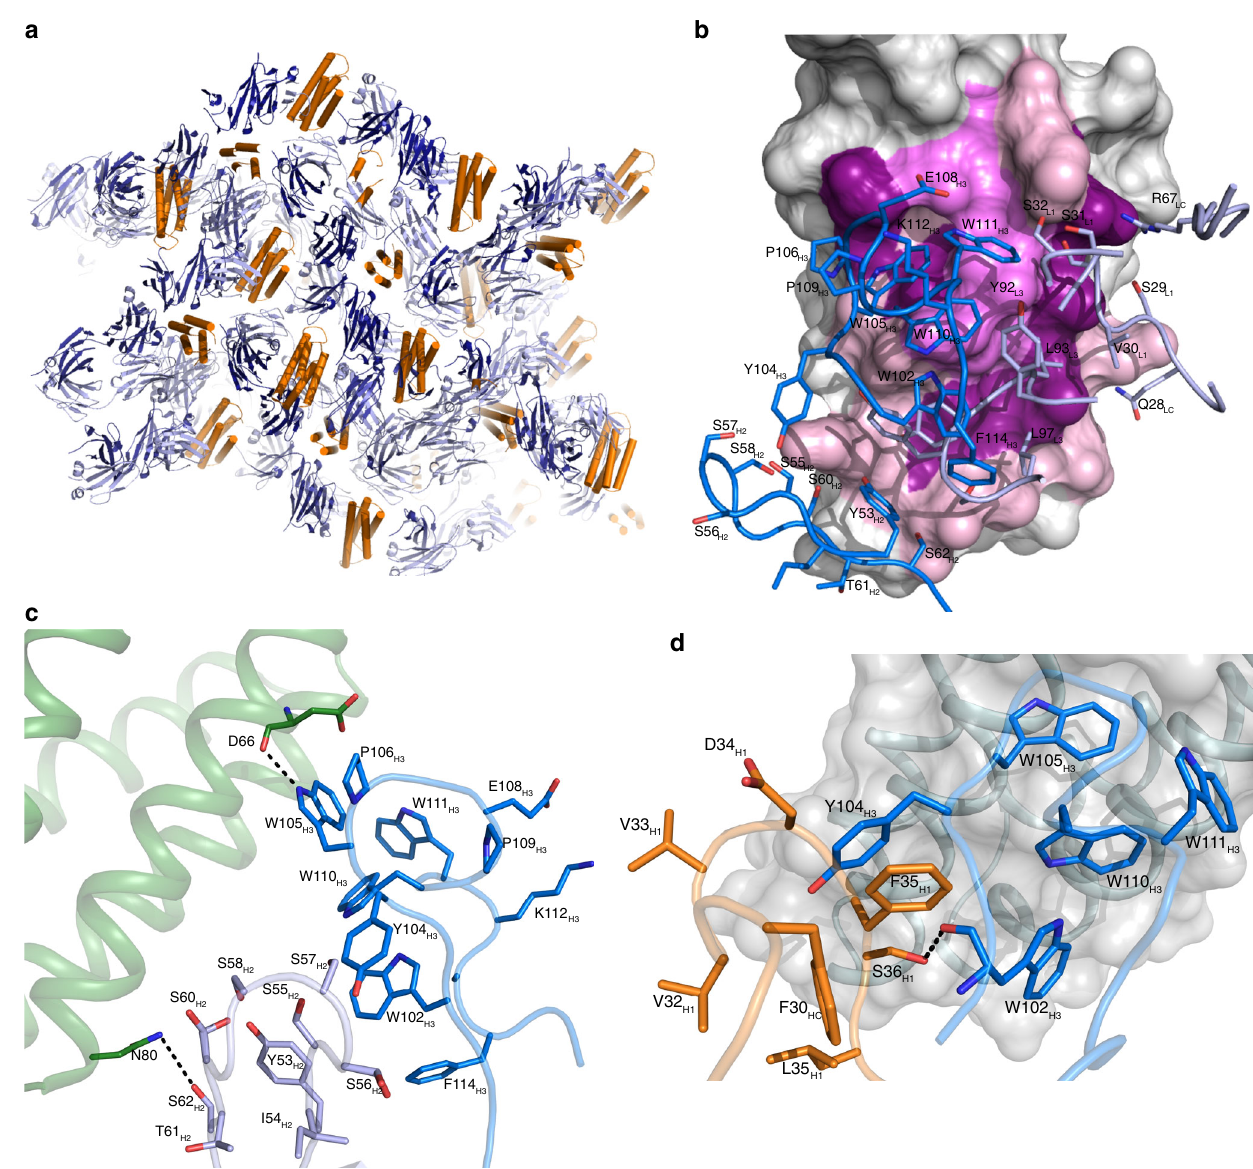
Fig. 4 Structural characterization of the BRIL – BAG2 complex. a Analysis of the crystal packing shows the contacts in the crystal lattice are mediated primarily by BRIL and the heavy chain (HC) and light chain (LC) of BAG2. BRIL is colored orange while the HC and LC of BAG2 are colored dark and light blue, respectively. b Detailed picture of BAG2 residues (shown in sticks) interacting with BRIL. The HC and LC CDRs are colored dark blue and light blue respectively. Residues of BRIL were colored according to their percentage of reduction in accessible surface area upon complex formation (10 – 49%, light pink; 50 – 70%, pink; >70%, magenta). c Interacting residues of CDR – H2 (light blue) CDR-H3 (dark blue) of BAG2. Selected H-bonding interactions are highlighted. d F35 H1 is involved in a π -stacking interaction with F30 HC and Y104 H3 while hydroxyl group of S36 H1 is hydrogen bonded with the main chain carbonyl oxygen of W102 H3 in the crystal structure. These interactions demonstrate the conservation of the aromatic residues and Ser/Thr in positions 35 and 36 of CDR-H1, respectively, in all the af fi nity-matured variants (Weblogo Plot in Fig. 3b). Subscripts H1, H2, H3, L1, L2, L3 denote the CDRs and subscripts HC and LC denote the scaffold — e.g., F35 H1 is a residue in CDR H1 while F30 HC is a residue in the HC scaffold, not in the structure determination of BRIL-fused GPCRs either by crystal- lography or by SP cryoEM.